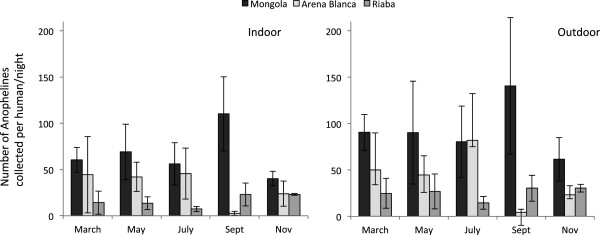
Anopheline mosquito density on Bioko Island, Equatorial Guinea in 2009. Number of anopheline mosquitoes collected by human landing collections indoors (left panel) and outdoors (right panel) per person per night in three locations. The dominant species in Mongola was An. gambiae s.s.; in Arena Blanca An. melas; and in Riaba both species were almost equally abundant. Bars indicate 95% confidence intervals.